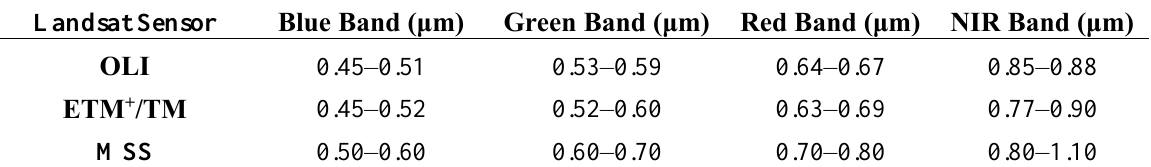
Table 3. Spectral bands for the Landsat sensors, whose SRF functions were obtained from USGS and used to simulate Landsat-based derived R rs using in situ measured R rs through Equation